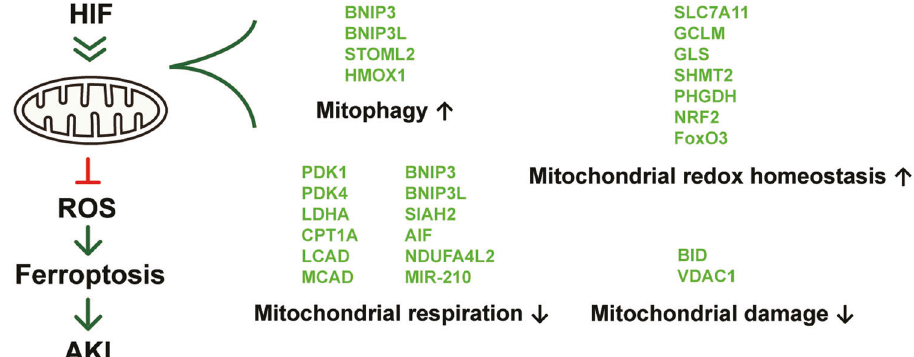
Fig. 3 Proposed mechanisms by which HIF can ameliorate ferroptosis in AKI. HIF regulates a series of genes that affect mitochondrial function. By promoting mitophagy and limiting mitochondrial aerobic respiration, the production of ROS and the active involvement